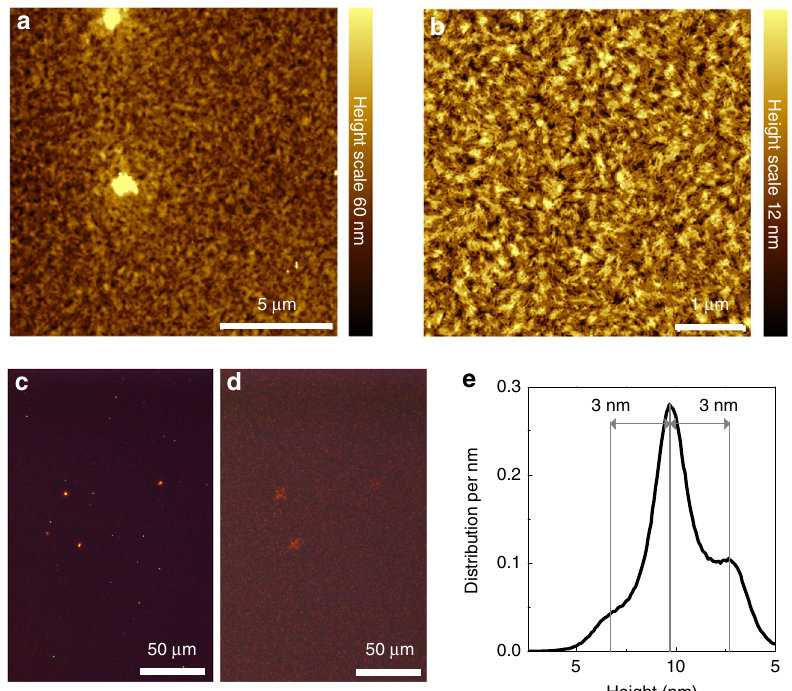
Fig. 2 Micro-morphological characterization of ProSQ-C16 thin fi lms. a , b Intermittent contact mode AFM images, and optical microscopy images c dark fi eld and d between crossed polarizers of typical ProSQ-C16 samples annealed at 180 °C. The optical microscopy images show the same sample area and are overexposed for better visibility. e Distribution of heights extracted from AFM image ( b